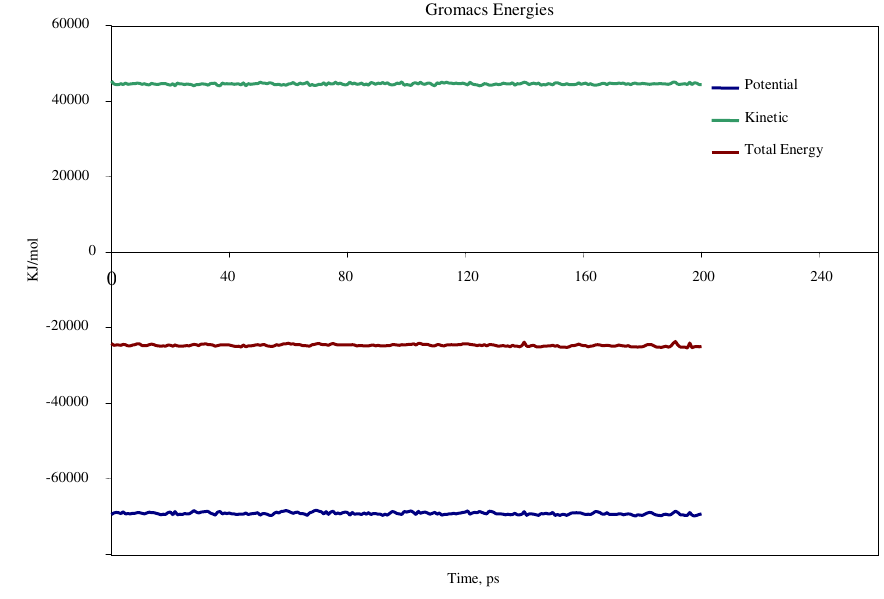
Figure 8. Plot of gromacs energies of Hsp90 using GROMOS96 force field